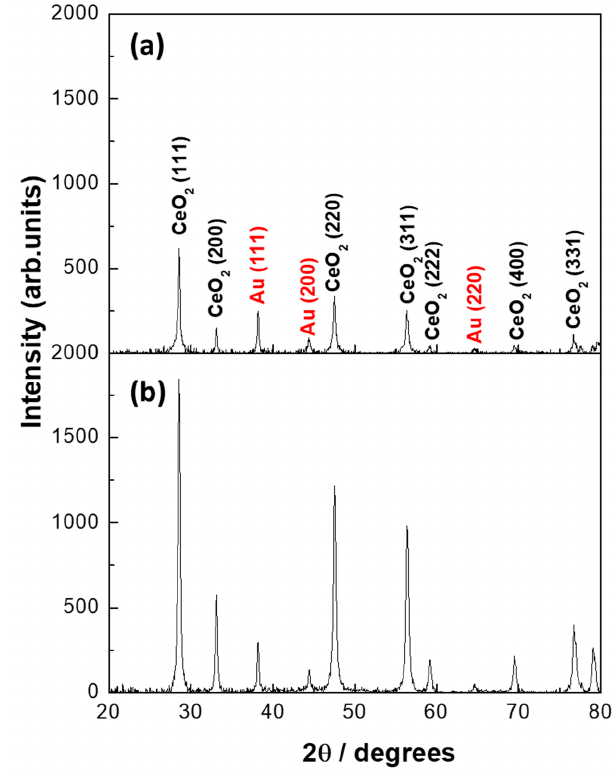
Figure 8. X-ray diffraction patterns of Au/CeO 2 catalysts prepared by ( a ) LVCC and ( b ) DP methods Figure 8. X-ray di ff raction patterns of Au / CeO 2 catalysts prepared by ( a ) LVCC and ( b ) DP methods after heat treatment in the CO/O 2 mixture (second light-off). after heat treatment in the CO / O 2 mixture (second light-o ff